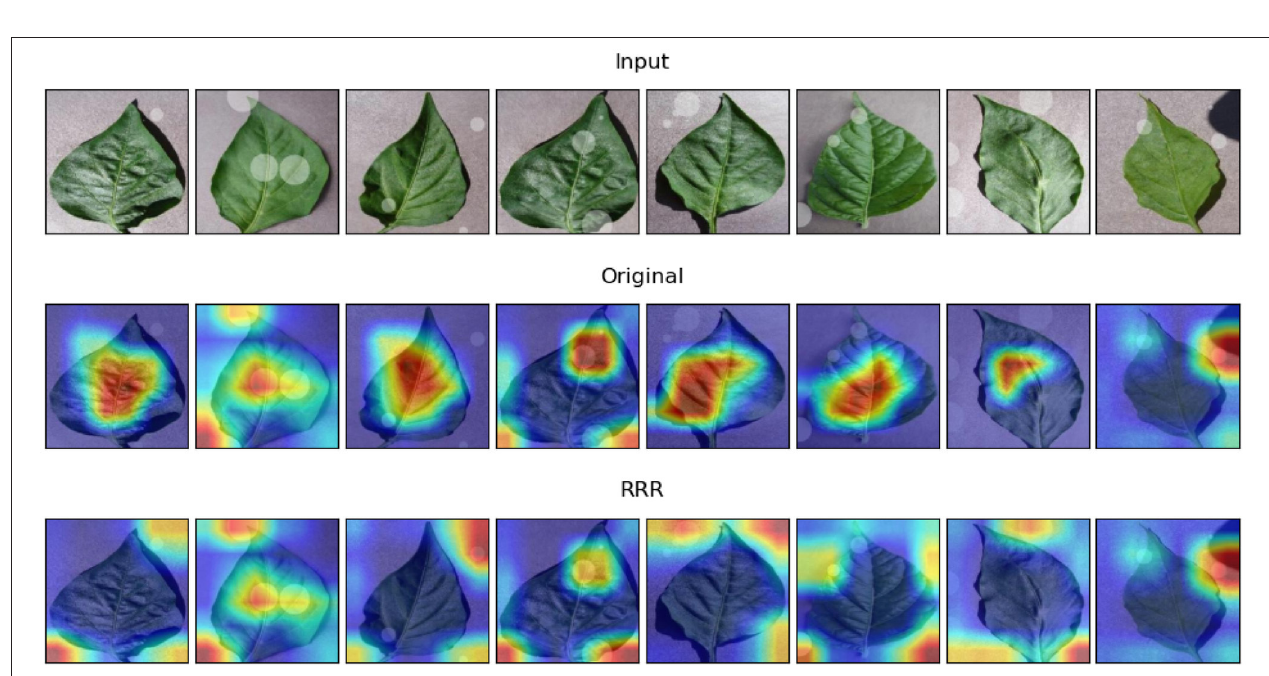
FIGURE 6 | Examples of the real masks of two species’ leaves. The labeled pixels in masks are red.